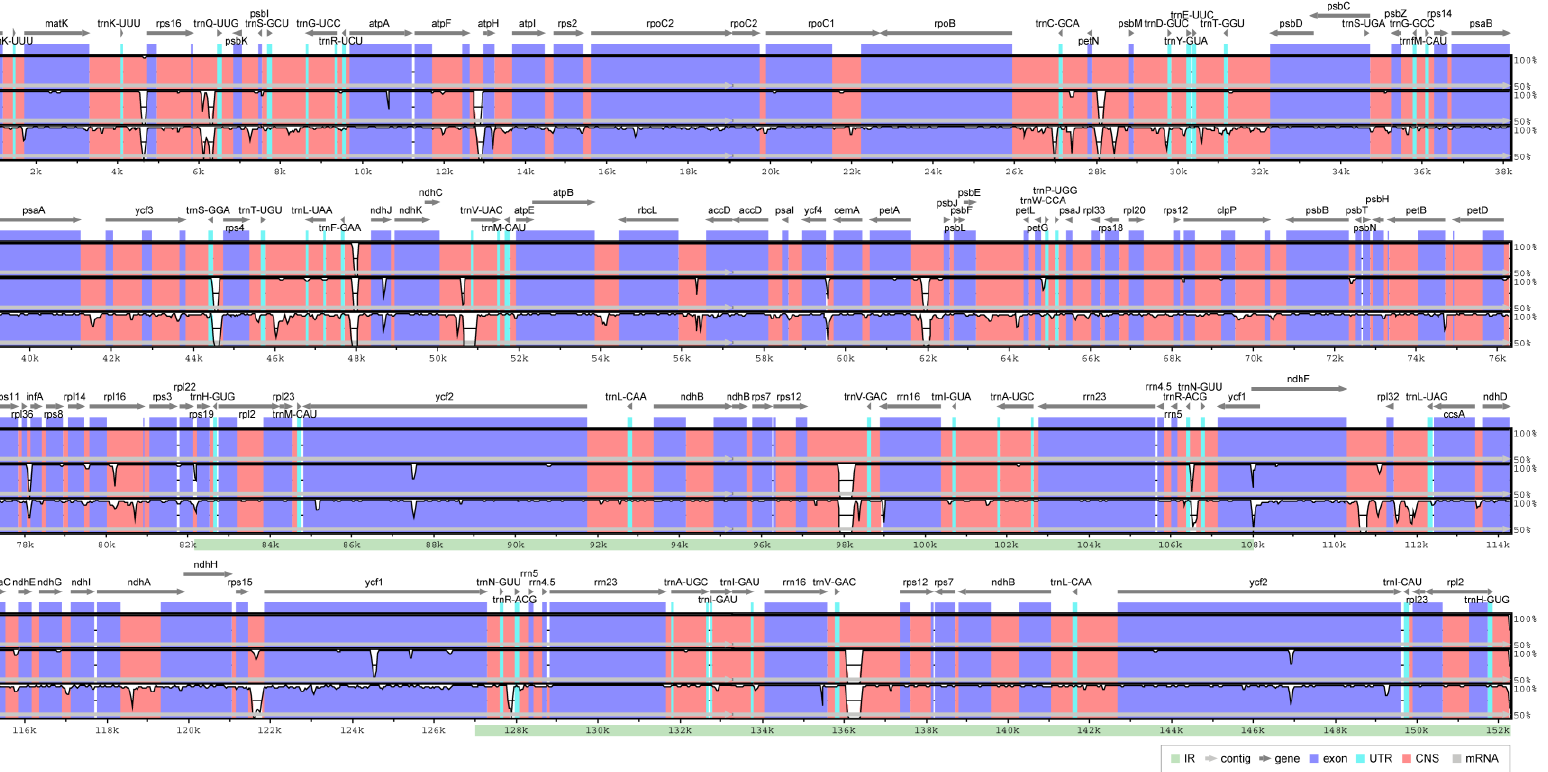
Figure 5. Visualization of the comparison of the three Iris cp genomes using mVISTA, with I. koreana as the reference. Different colors represent different coding and non-coding gene regions. Dark-blue blocks: conserved genes, light-blue blocks: transfer RNAs (tRNAs) and ribosomal RNAs (rRNAs), red blocks: conserved non-coding sequences (CNS). The vertical scale with white represents the regions with higher levels of sequence variations within the chloroplast genome.